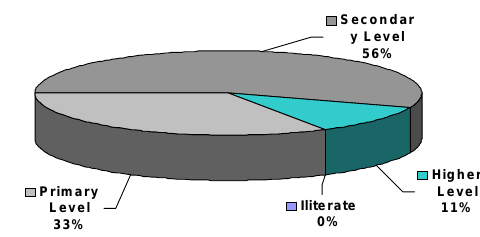
Figure 2: Genderwise and Marital Status of Infected Patients (n=9)